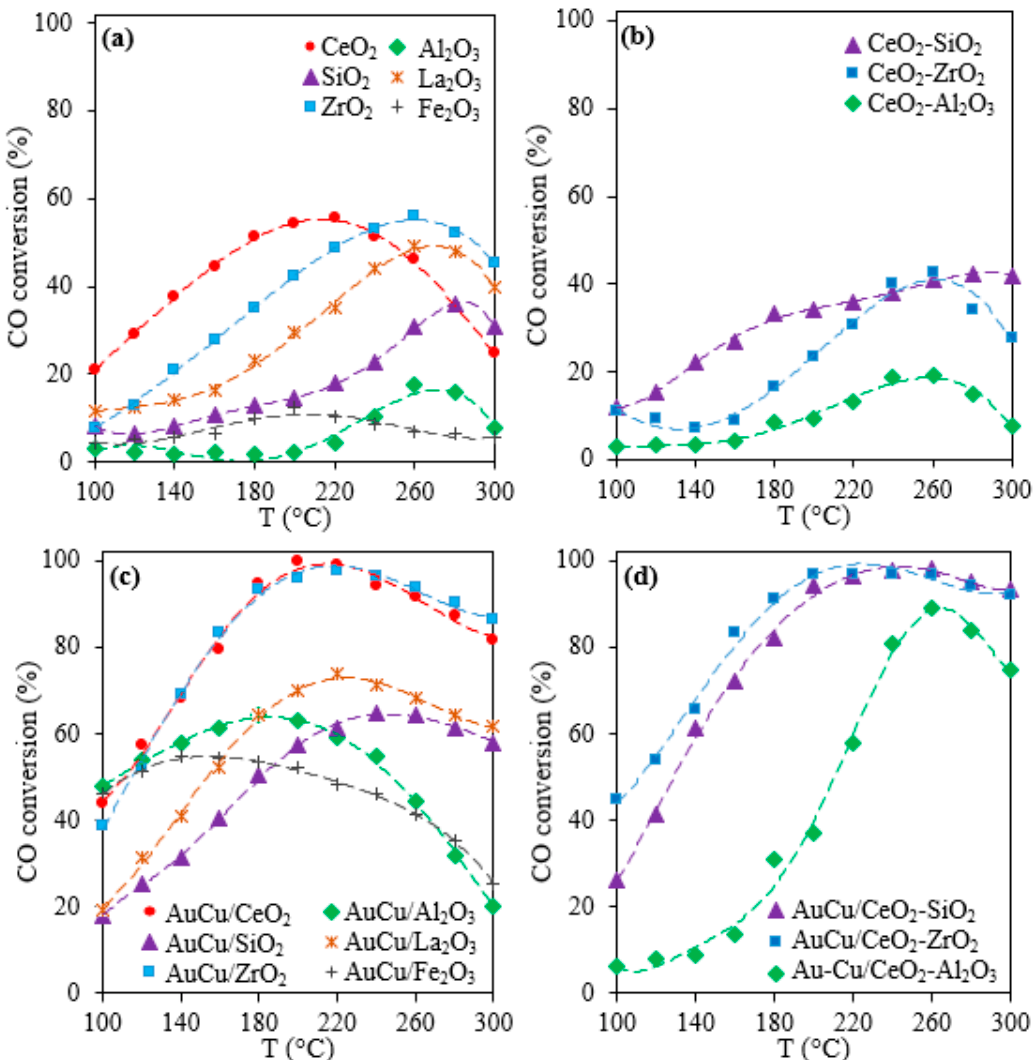
Figure 2. CO conversion obtained in the Cleanup reactor with supports ( a , b ) and supported 1 wt% Au–1 wt% Cu catalysts ( c , d ). Syngas feed: 7.8% H 2 , 2.0% CO, 0.5% CO 2 , 0.3% CH 4 , 1.4% H 2 O, 1.8% O 2 , 6.8% N 2 , and 79.4% Ar. Reaction conditions: Space velocity (SV) = 6.5 ± 0.2 L/g cat *min and 0.3 g of the catalytic bed.